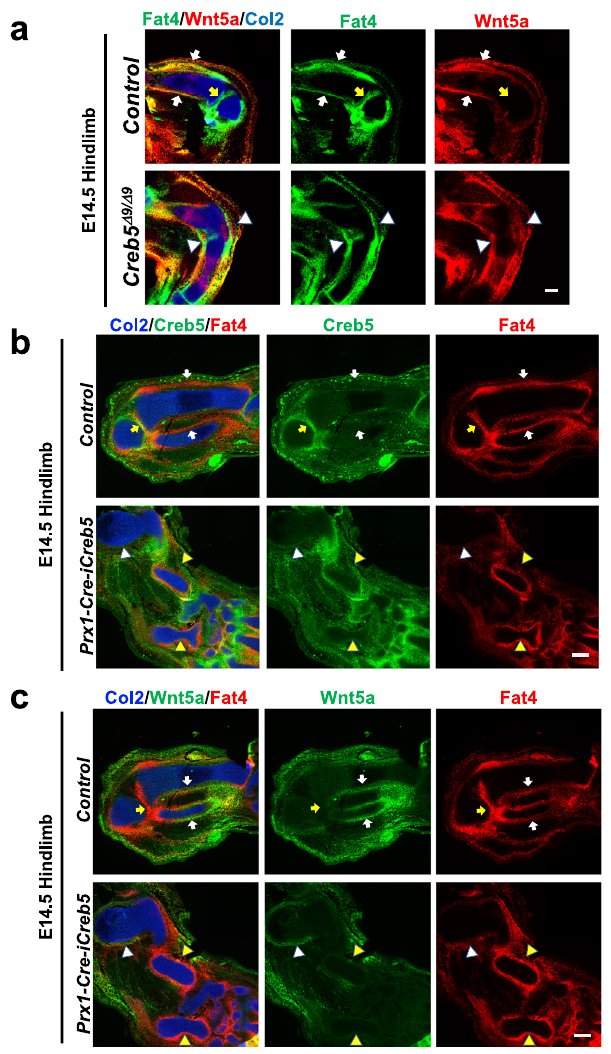
Fig.8|MisexpressionofiCreb5-HA (Prx1-Cre) promotesformationofaFat4 + ,Wnt5a − perichondrium. Gene expression assayed by RNAscope FISH in the hindlimbs of an E14.5 Creb5 Δ 9/ Δ 9 embryo or control littermate ( a ) or in serial sections of the forelimbs of anE14.5 Prx1-Cre-iCreb5 embryo orcontrol littermate ( b , c ).In control limbs, the Fat4 high , Wnt5a low articular perichondrium (yellow arrows) and Fat4 low , Wnt5a high metaphyseal/diaphyseal perichondrium (white arrows) are indicated. In Creb5 Δ 9/ Δ 9 mutant limbs, the perichondrial cells expressing both Wnt5a and mutant Creb5 Δ 9/ Δ 9 (white arrowheads) are indicated. In Prx1-Cre-iCreb5 limbs: Fat4 low , Wnt5a high perichondrium (white arrowheads) or Fat4 high , Wnt5a low perichondrium (yellow arrowheads) are indicated. In Prx1-Cre-iCreb5 embryos, perichondrial expression of iCreb5-HA (Prx1-Cre) promotes high level expression of Fat4 in the peri- chondrium,blocksexpressionofWnt5ainthissametissue(yellowarrowheads)and inhibits chondrocyte hypertrophy. Perichondrium surrounding cartilage elements that display chondrocyte hypertrophy in Prx1-Cre-iCreb5 embryos continue to express WT levels of Wnt5a (white arrowheads). Similar results were obtained in two independent biological repeats. Scale bar equals 200